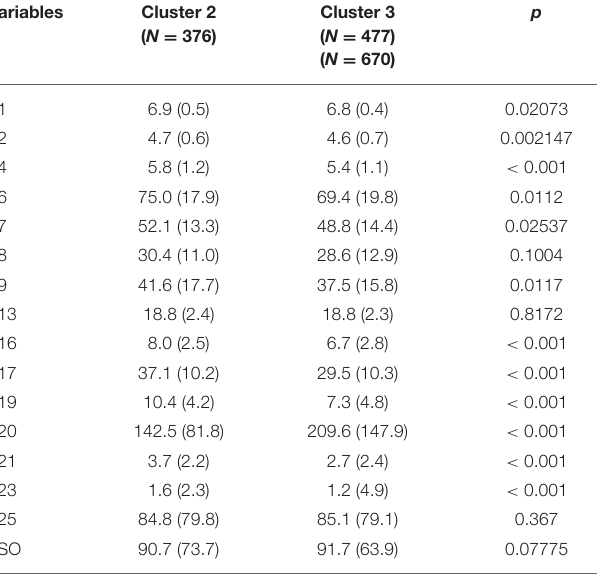
TABLE 6 | Post hoc comparisons of Cluster 2 and Cluster 3 of the variables not used for creating the clusters.